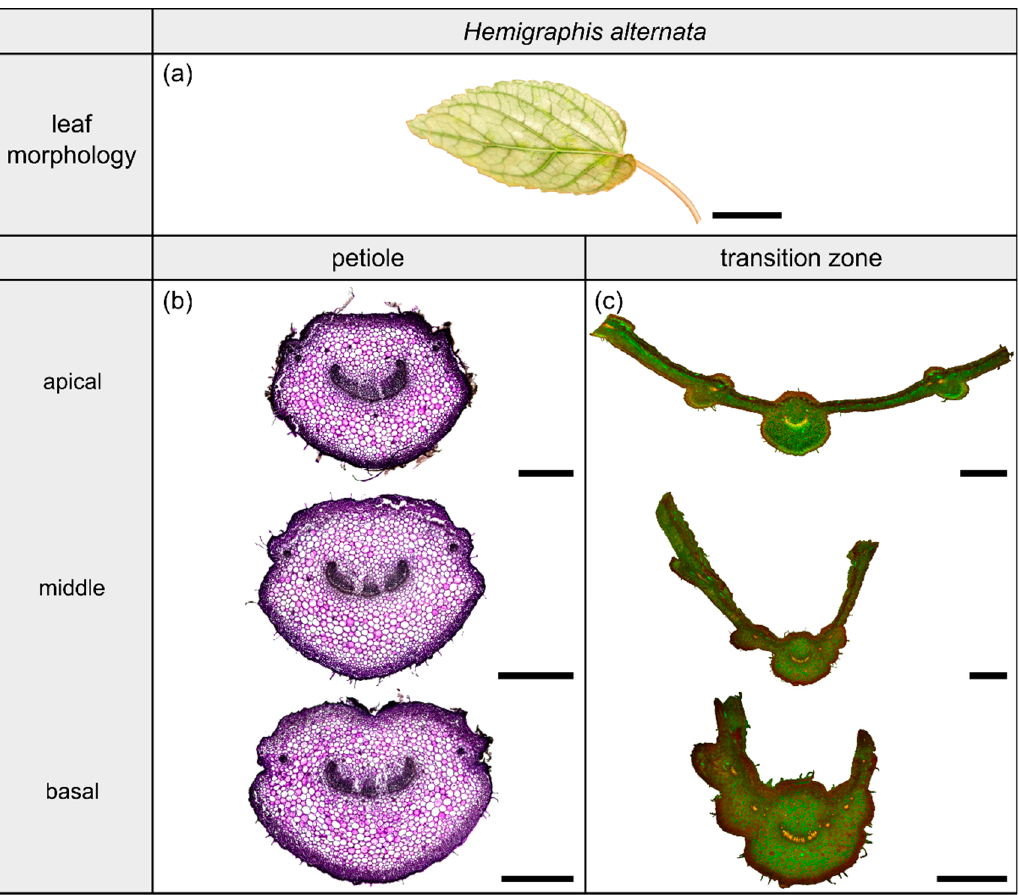
Figure 5. Morphology and anatomy of the foliage leaf of Hemigraphis alternata ( a ). The thin-sections of the transition zone are stained with acridine orange ( c ), whereas the thin-sections of the petiole are stained with toluidine blue ( b ). The scale bar of the leaf morphology equals 2 cm and those of the anatomical sections equal 1 mm.